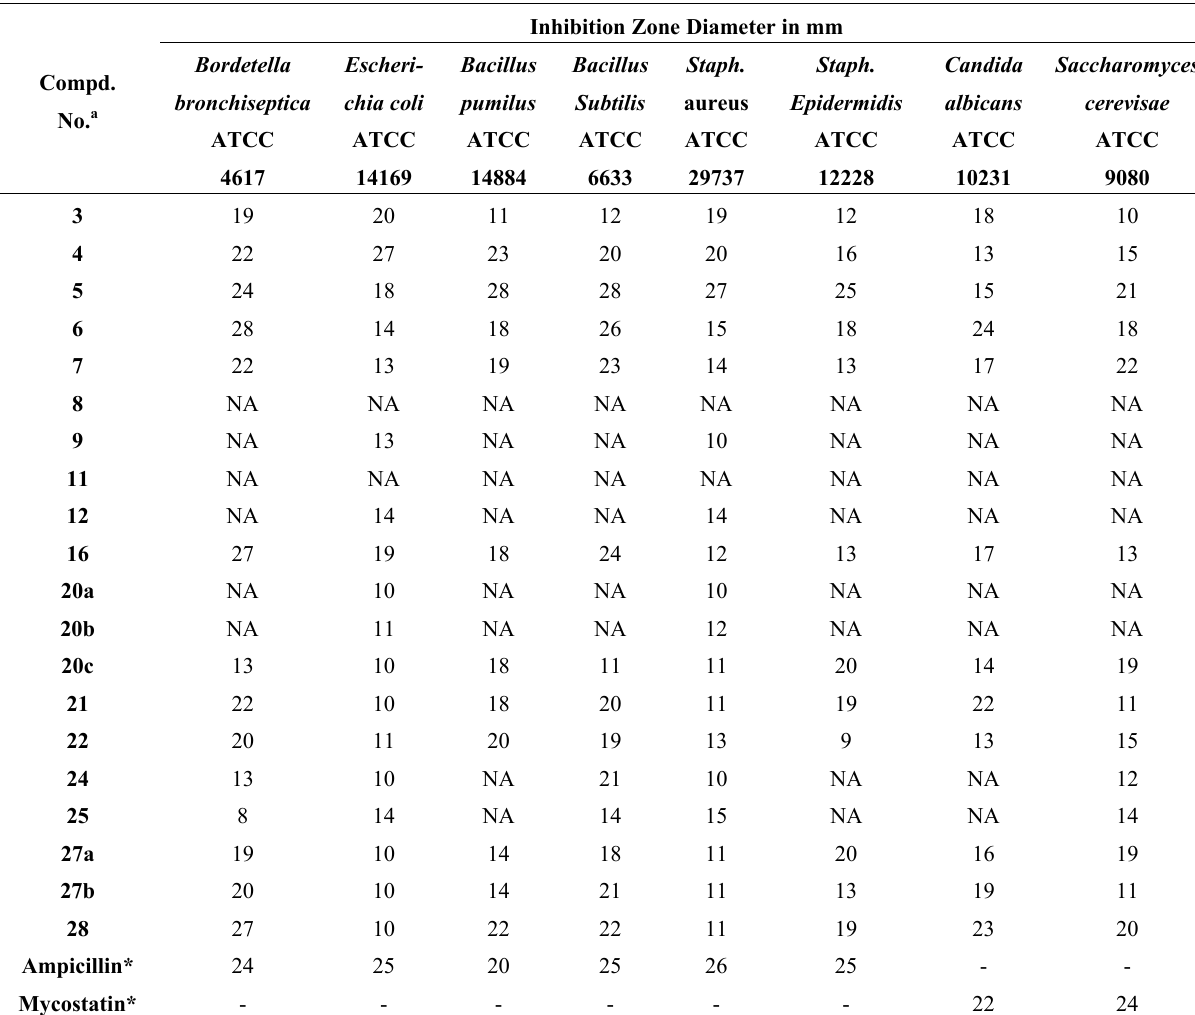
Table 1. Antibacterial screening of the synthetic compounds.